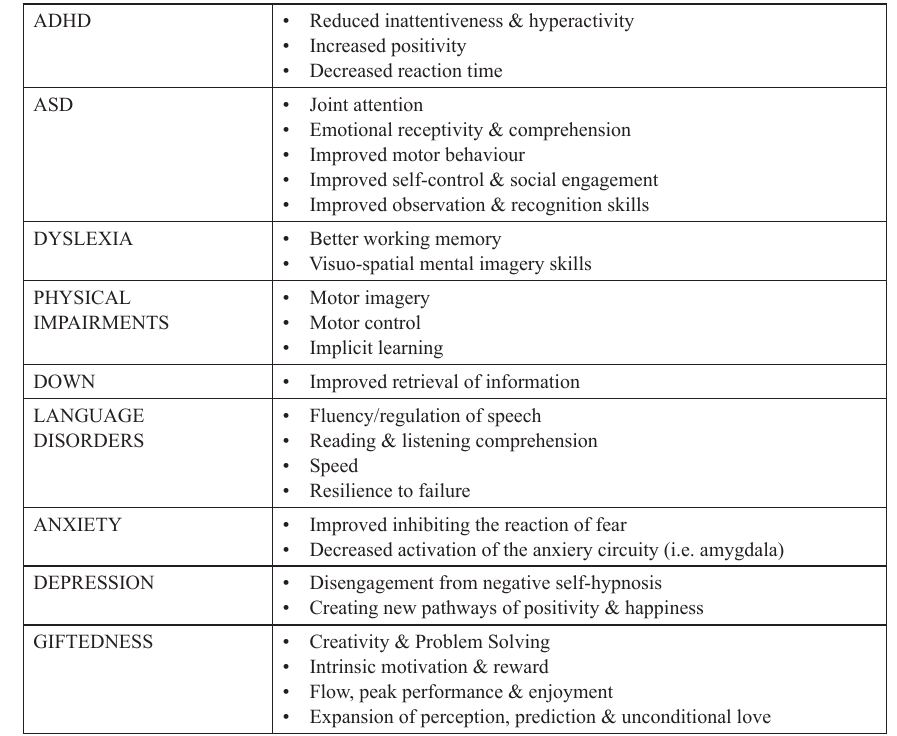
Table 1. The impact of clinical hypnosis in special education